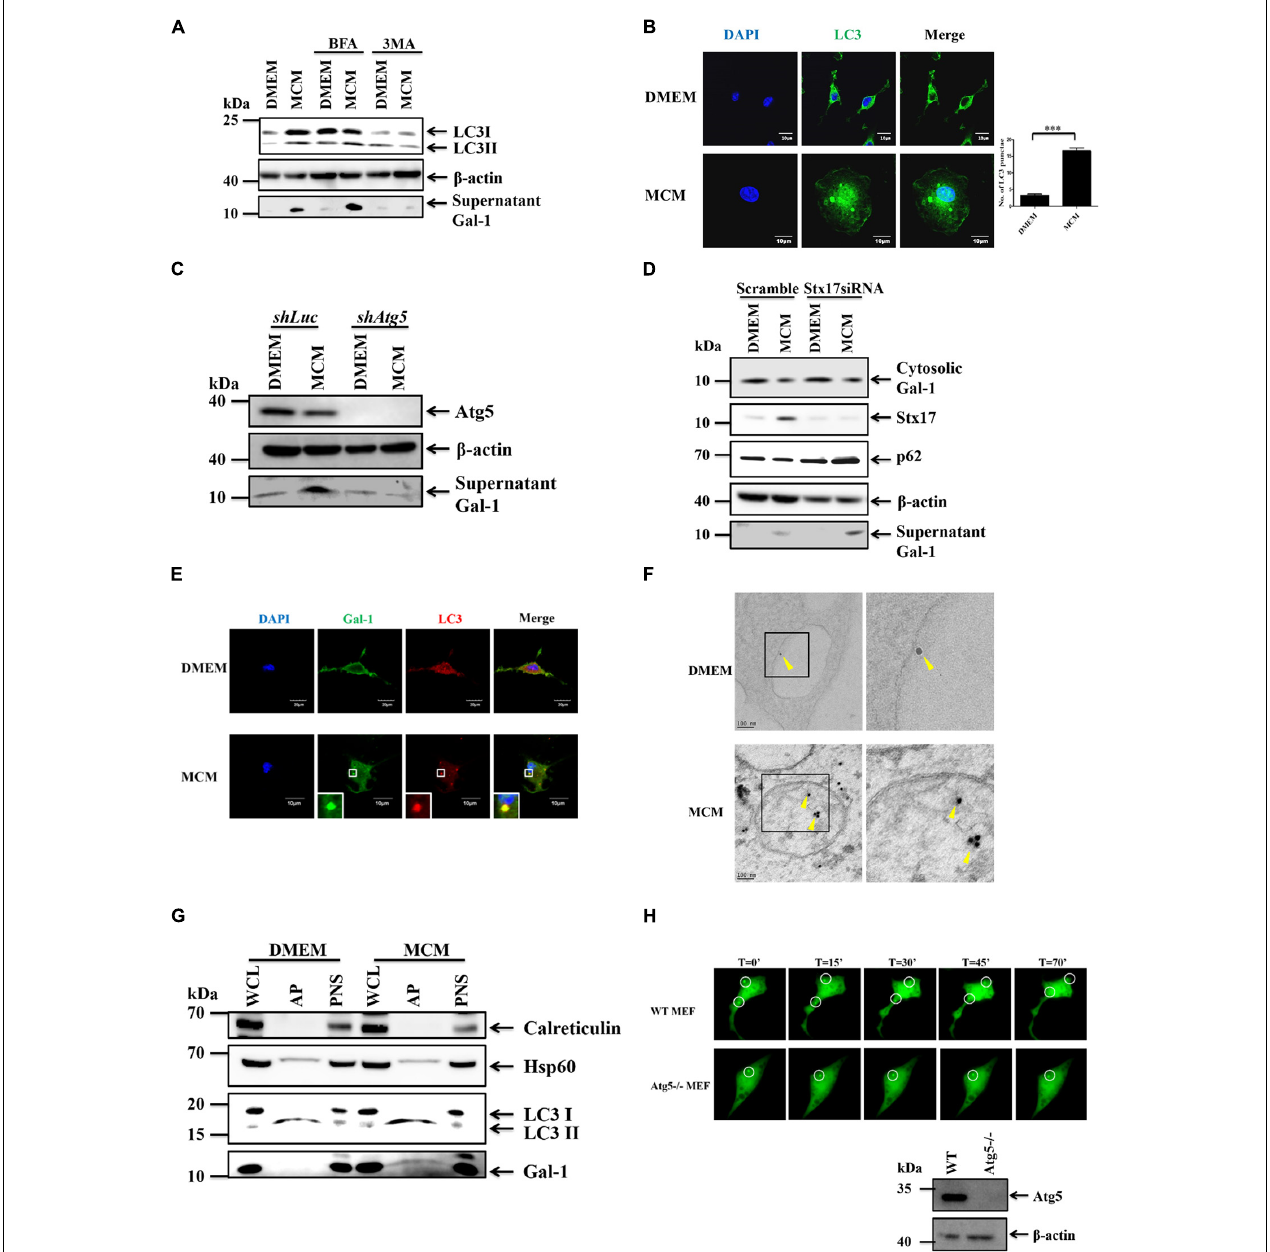
FIGURE 2 | Gal-1 secretion is mediated by autophagy. (A) BMDMs were pretreated with 3MA (2 mM) or Brefeldin A (30 nM) for 1 h and then treated with MCM for another 24 h. The expression of cytosolic LC3-I/II, β -actin, and supernatant G-1 proteins was determined by Western blotting. All blots were derived from a single experiment. (B) BMDMs were treated with MCM for 12 h and stained with anti-LC3 antibody. The LC3 aggregation (green) was observed by confocal microscopy. Scale bar = 10 µ m. (C) RAW 264.7 cells stably expressing luciferase (Luc) or Atg5 shRNA were treated with MCM for 24 h. The expression of cytosolic Atg5, β -actin, and supernatant Gal-1 proteins was determined by Western blotting. All blots were derived from a single experiment. (D) RAW264.7 cells were transfected with control or Stx17 siRNA at 10 µ M for 24 h and then treated with MCM for another 24 h. The expression of cytosolic Gal-1, Stx17, p62, β -actin, and supernatant Gal-1 proteins was determined by Western blotting. All blots were derived from a single experiment. (E) BMDMs were treated with MCM for 12 h and stained with anti-Gal-1 (green) and -LC3 (red) antibodies. The distribution of these proteins was analyzed by confocal microscopy. Scale bar = 10 µ m. (F) BMDMs were treated with MCM for 6 h to detect Gal-1 by immunoelectron microscopy. Gold nanoparticle-labeled Gal-1 (arrow bead) in the autophagosomes was observed under a transmission electron microscope. Scale bar = 60 nm. (G) RAW 264.7 cells were treated with MCM for 6 h to isolate autophagosomes. The expression of calreticulin, HSP60, LC3-I/II, and Gal-1 proteins in different cell components was determined by Western blotting. WCL: whole cell lysates; PNS: post-nuclear supernatants; AP: autophagosomes. All blots were derived from a single experiment. (H) WT and Atg5-/- MEF cells were transfected with Gal-1-GFP to monitor the Gal-1 trafficking by TIRF microscopy. Selected frames from time-lapse TIRF microscopy with time intervals in seconds are shown. The protein expression of Atg5 of WT and Atg5-/- MEFs was determined by Western blotting (bottom right corner). All blots were derived from a single experiment.